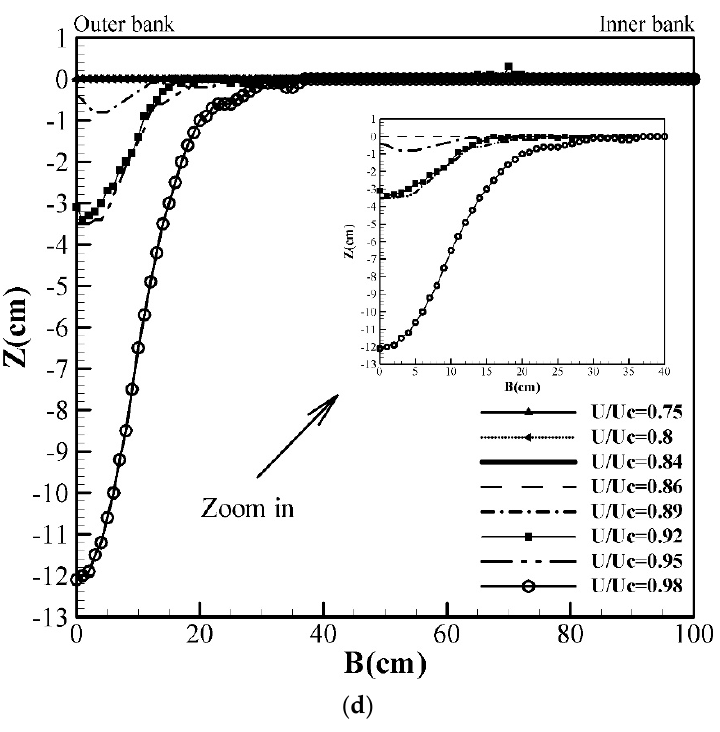
Figure 6. Instances of variations in the lateral bed profiles at ( a ) 45-, ( b ) 90-, ( c ) 135-, and ( d ) 180-degree angles of the upstream bend.